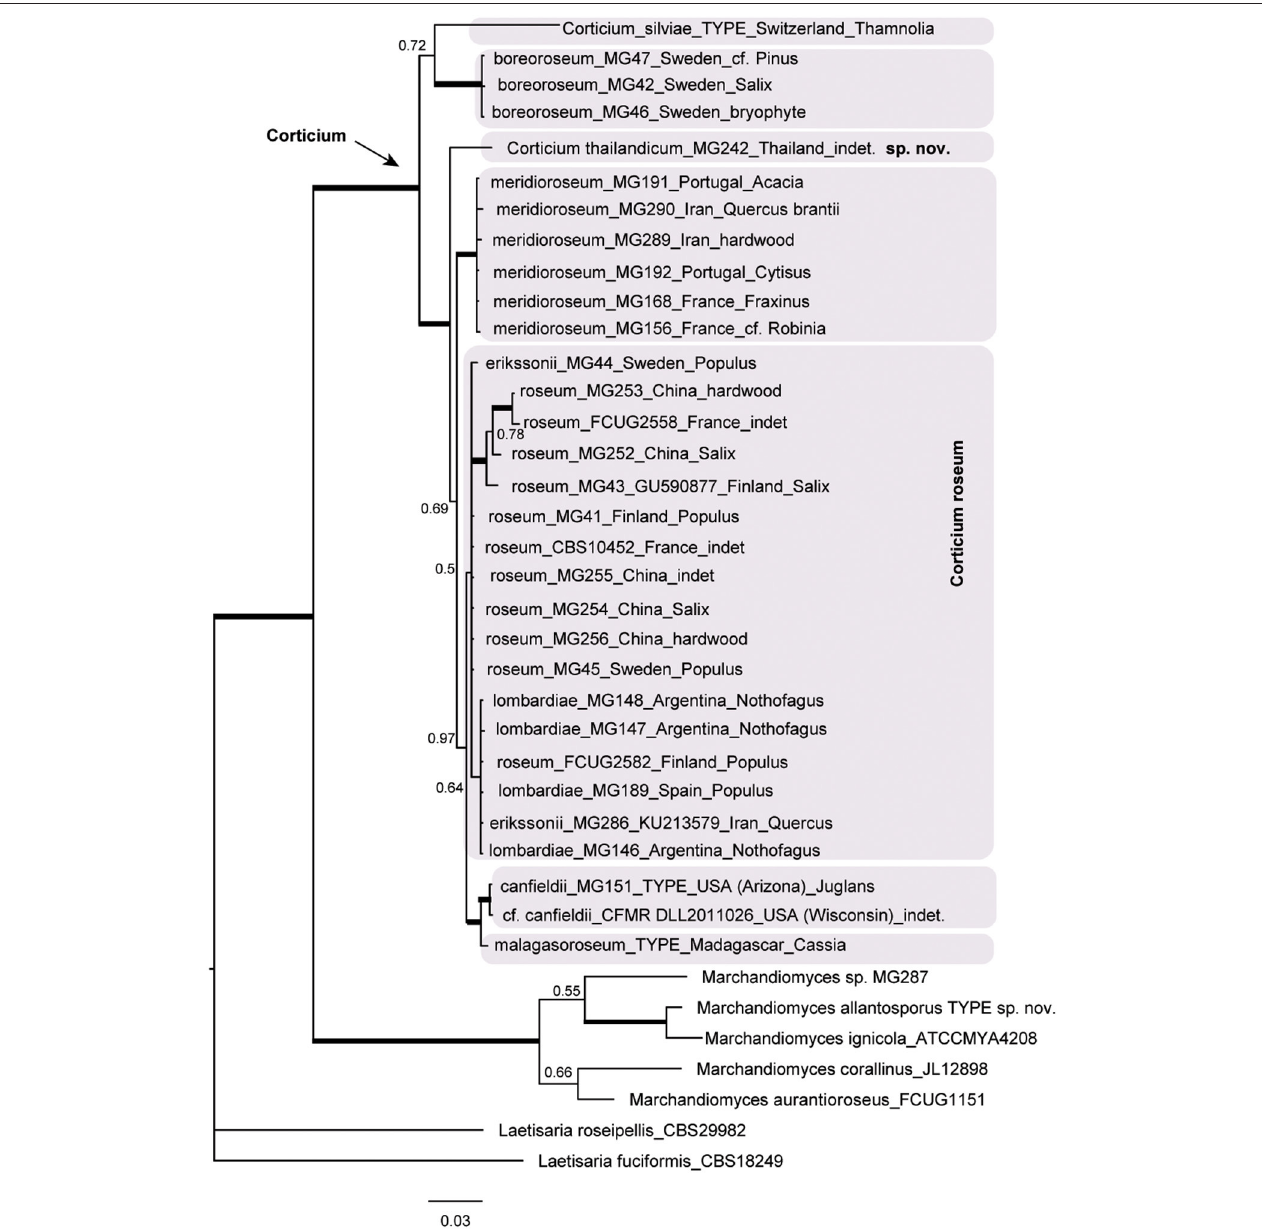
FIGURE 4 | The ITS phylogram of species in Corticium . Each pink box represents a Corticium species. Country of collection and substrates are shown on the branches. Branches in bold the posterior probability = 1.00. The scale bar represents the expected changes per site.